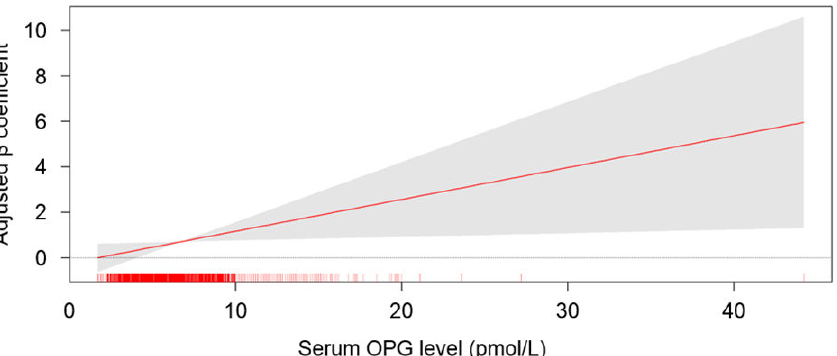
Figure 3. Restricted cubic spline of serum OPG on ARV of SBP. Adjusted β coefficient of serum OPG as a continuous variable for ARV of SBP is depicted. The model was adjusted for age, gender, Charlson comorbidity index, smoking history, BMI, SBP, DBP, medication (ACEi/ARBs, diuretics, number of antihypertensive drugs, statins), hemoglobin, albumin, HDL-C, fasting serum glucose, hs-CRP, 25(OH) vitamin D levels, eGFR, and 24 h urine protein. Abbreviations: OPG, osteoprotegerin.